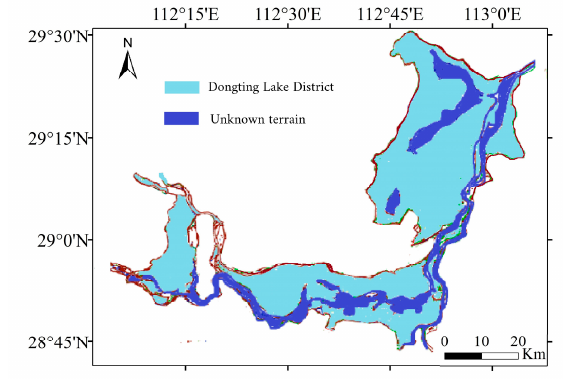
Figure 19. Ratio figure of unknown terrain.